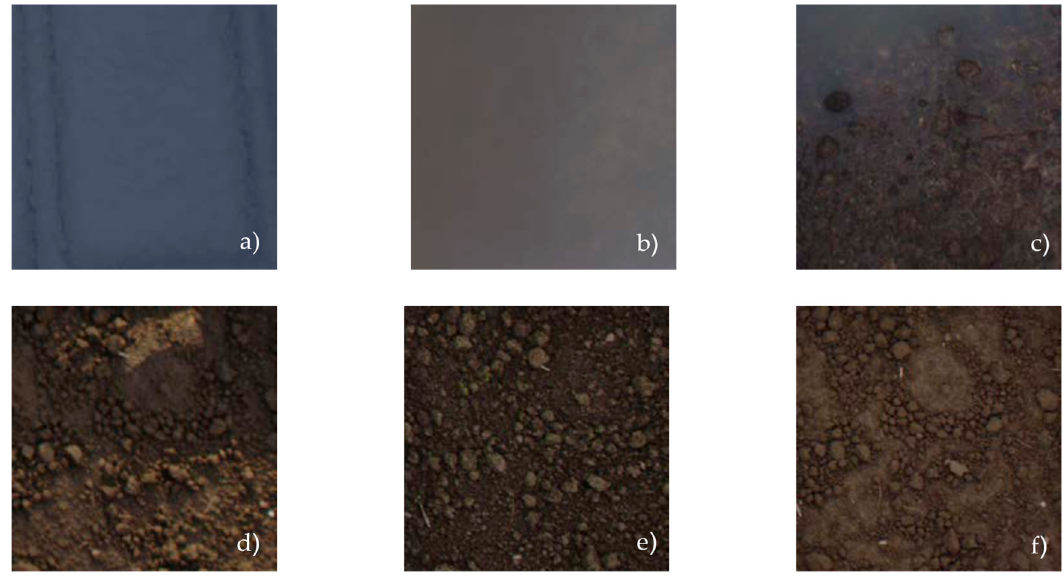
Figure 2. Examples of images that are discarded: snow ( a ); fog ( b ); standing water ( c ); sunlight distribution ( d ); and frozen surface ( e ). The last image ( f ) is an example of an image accepted for further analysis.